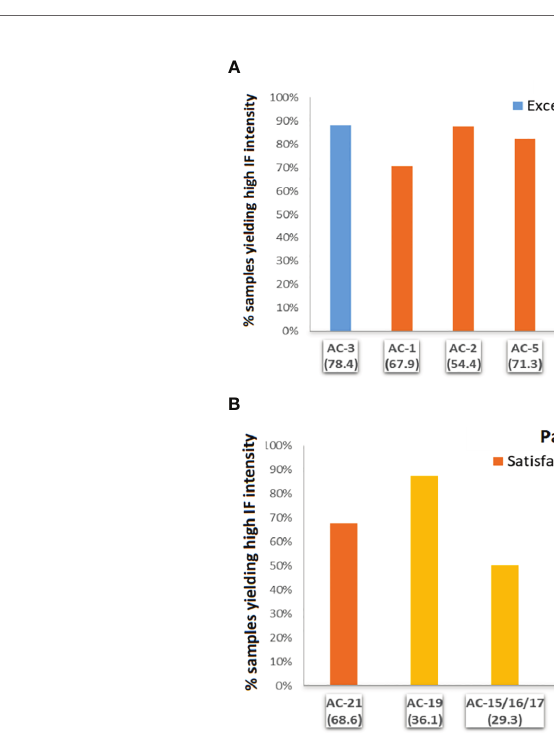
FIGURE 2 | Robustness of the various HEp-2-IFA patterns using different HEp-2 slide brands according to intensity of immuno fl uorescence intensity. (A) Nuclear patterns: AC-1, homogeneous; AC-2, dense fi ne speckled; AC-3, centromere; AC-4, fi ne speckled; AC-5, coarse speckled; AC-6, multiple nuclear dots; AC-7, few nuclear dots; AC-11/12, nuclear envelope; AC-XX, atypical. (B) Cytoplasmic patterns: 15/16/17 ( fi brillary); AC-18, rods and rings; AC-19, dense fi ne speckled; AC- 20, fi ne speckled; AC-21, mitochondria like. Robustness de fi ned according to the pattern reproducibility score (PRS): excellent (75>PRS), satisfactory (50>PRS ≤ 75), moderate (25>PRS ≤ 50), poor (1 ≥ PRS ≤